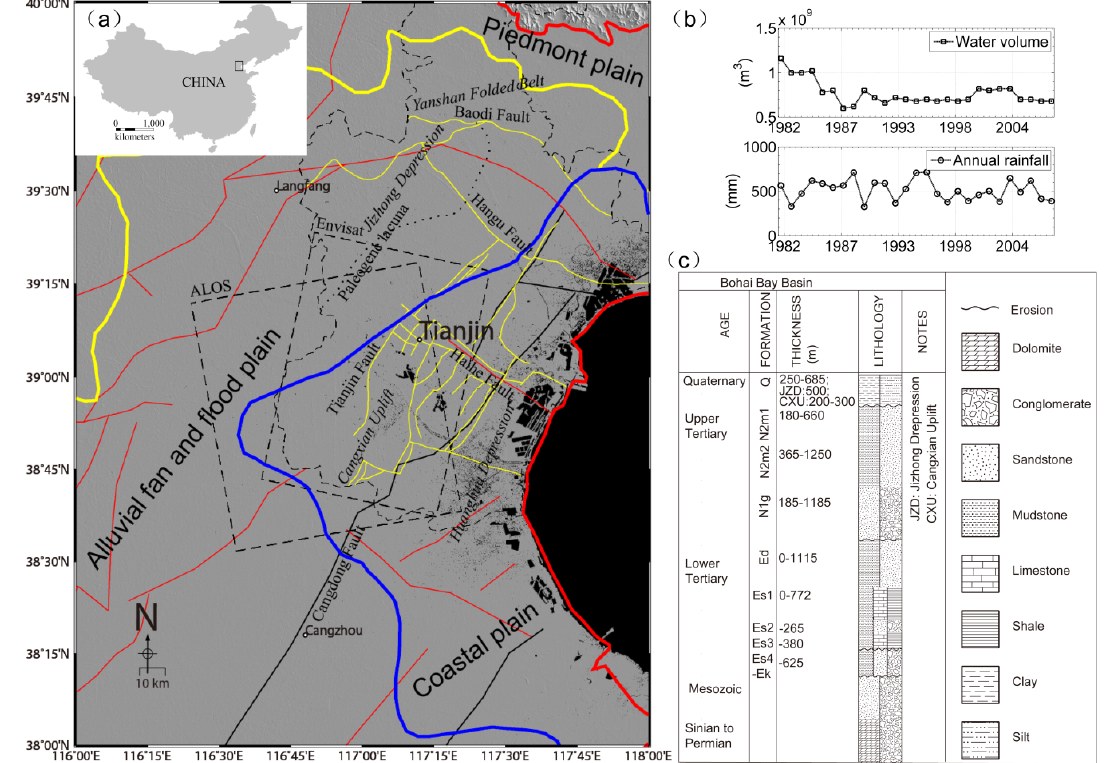
Figure 1. ( a ) The tectonic framework of the Northern China Plain. Boundary of North China Plain is in thick red line. Piedmont plain, alluvial fan and flood plain, and coastal plain in North China Plain are bounded by thick yellow and blue lines. Major faults and subsidiary faults in North China Plain are shown in thin black and red solid lines, respectively [19]. Palaeogene lacuna (missing line of Paleogene system) is in thin dotted line, while further details of the fault system in Tianjin are shown by thin yellow solid lines [20]. Locations of major cities in this area are shown. Envisat ASAR frame, ALOS PALSAR frame, and political boundary of Tianjin are outlined with dashed lines; ( b ) Annual groundwater pumping volume and rainfall in Tianjin City from 1980 to 2007 (after [5]); ( c ) Stratigraphy in Bohai Bay Basin (after [21–23]). The upper Tertiary formations can be divided into Neogene Minghuazhen (Nm) and Guantao (Ng) groups. The lower Tertiary formations can be divided into Eogene Dongying (Ed), Shahejie (Es), and Kongdian (Ek) formations.